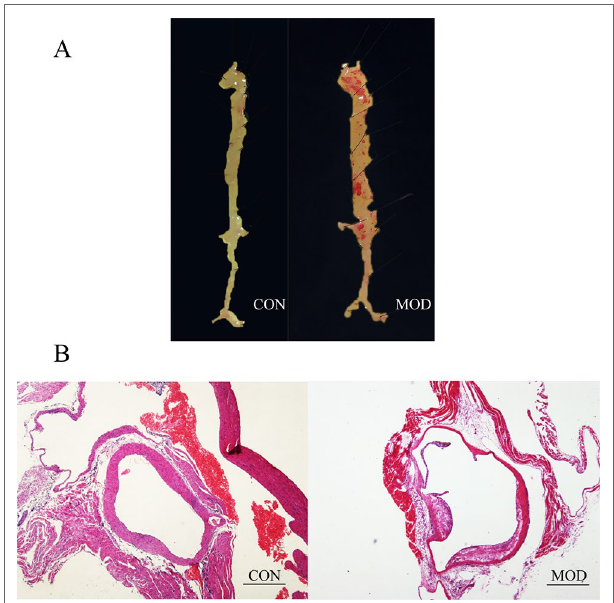
FIGURE 1 | (A) Atherosclerotic (AS) formation of ApoE −/− mice after a high-fat diet for 13 weeks compared with C57BL/6 mice by “En face” observation. (B) AS formation of ApoE −/− mice after a high-fat diet for 13 weeks compared with C57BL/6 mice by hematoxylin–eosin (H&E) staining on light microscope. CON: C57BL/6 mice, MOD: ApoE −/− mice (bar = 500 μm).